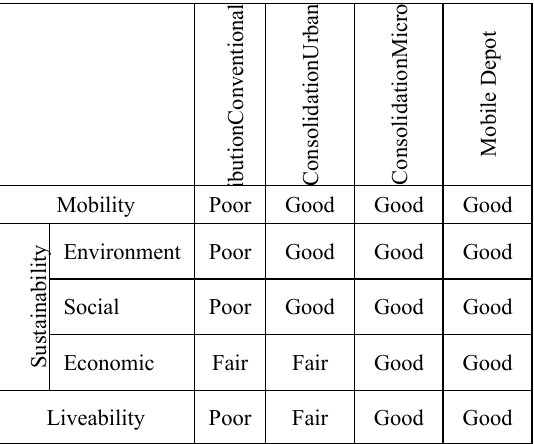
Table 1. The Evaluation of City Logistics